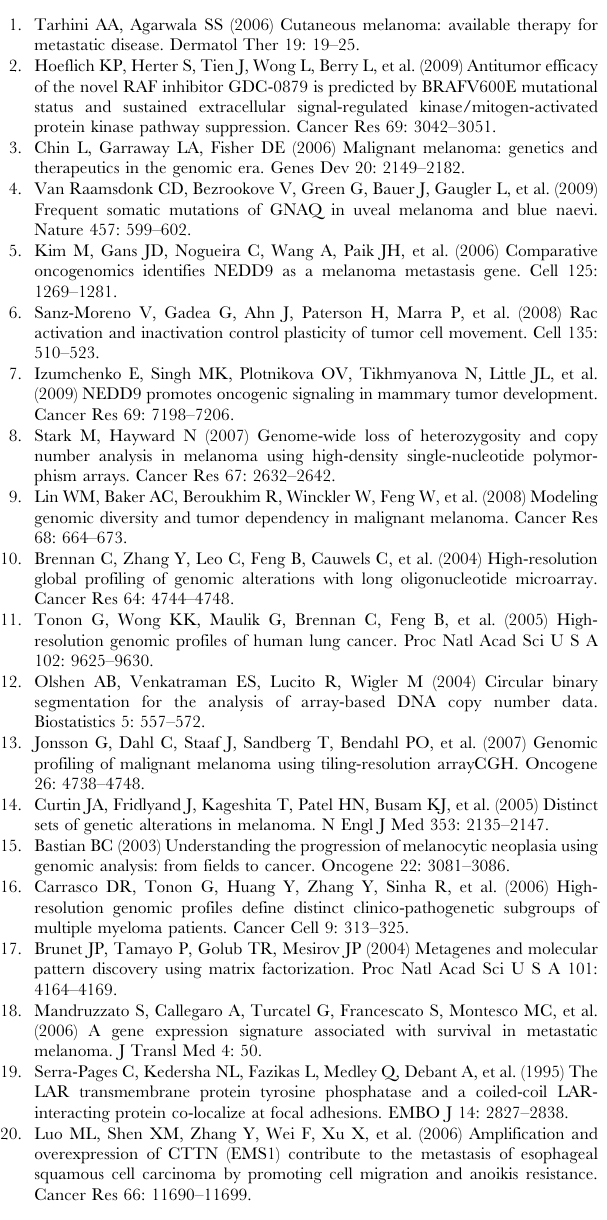
Table S2 Annotation of samples from Memorial Sloan Ketter- ing and the Brigham and Women’s